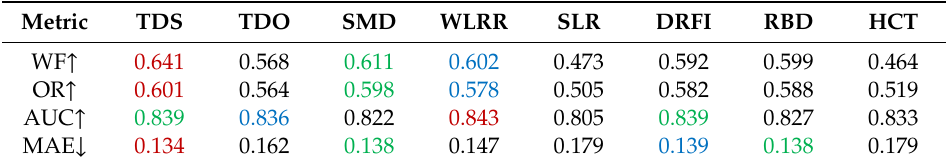
Table 1. Result on iCoSeg dataset in terms of weighted F β –measure (WF), mean absolute error (MAE), overlapping ration (OR), and area under the RO curve (AUC).